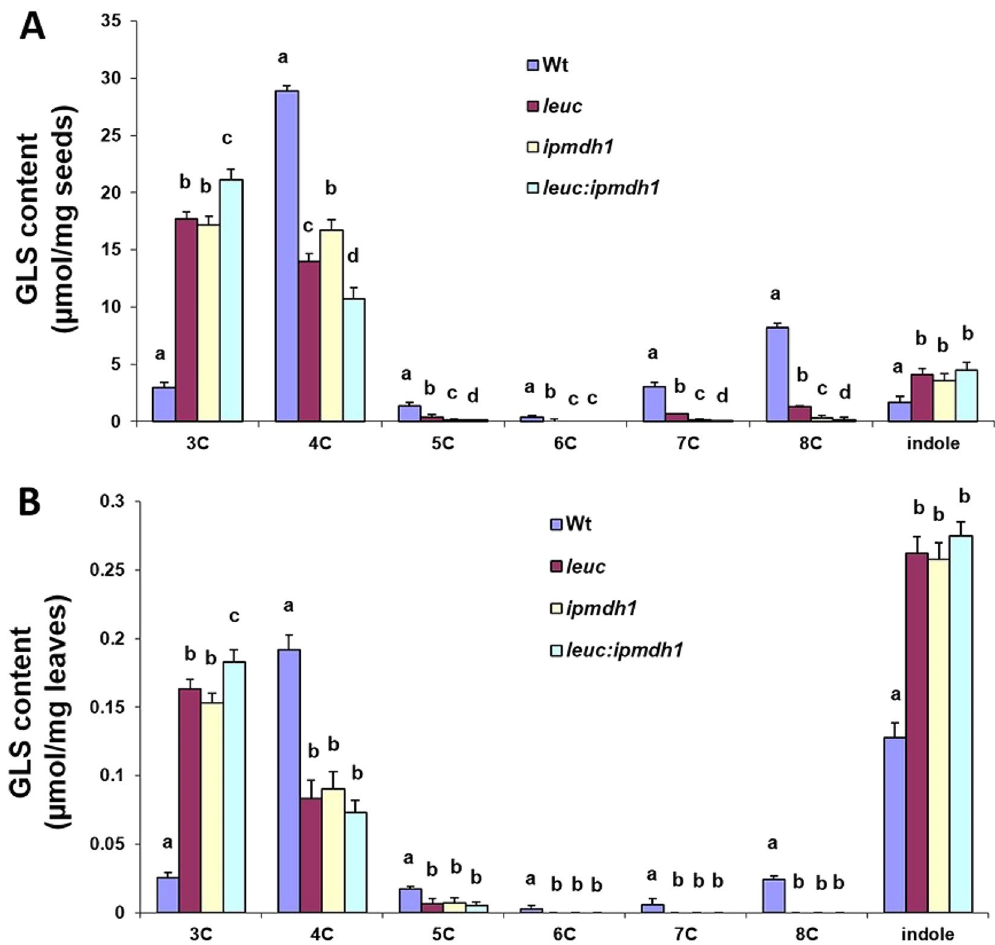
Figure 4. GLS pattern in wild-type (Wt), leuc , ipmdh1 and leuc : ipmdh1 mutants. Aliphatic GLSs are grouped according to their chain length (C3–C8), and indole GLS were summed as one group. GLS concentrations